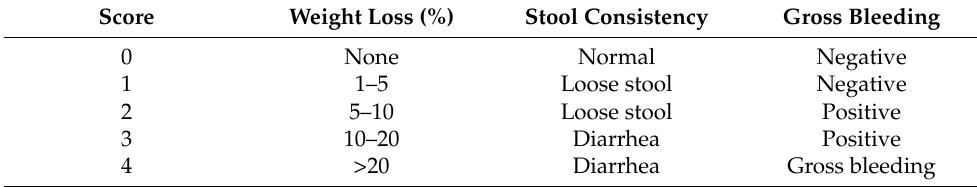
Table 1. Criteria of disease activity index